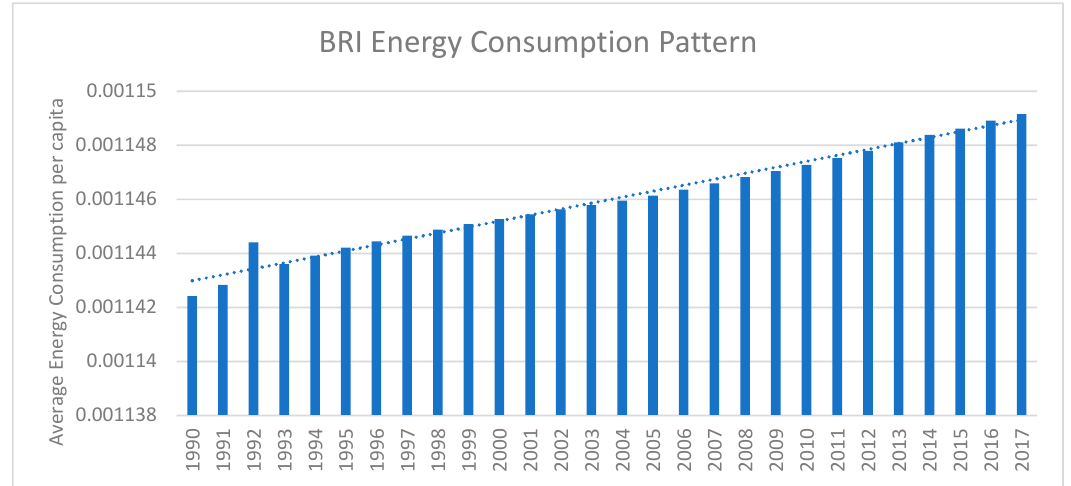
Figure 1. Pattern of Energy Consumption in BRI.